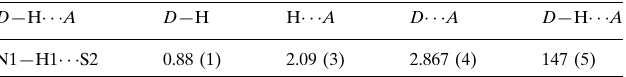
Hydrogen-bond geometry (A˚ , (cid:4)